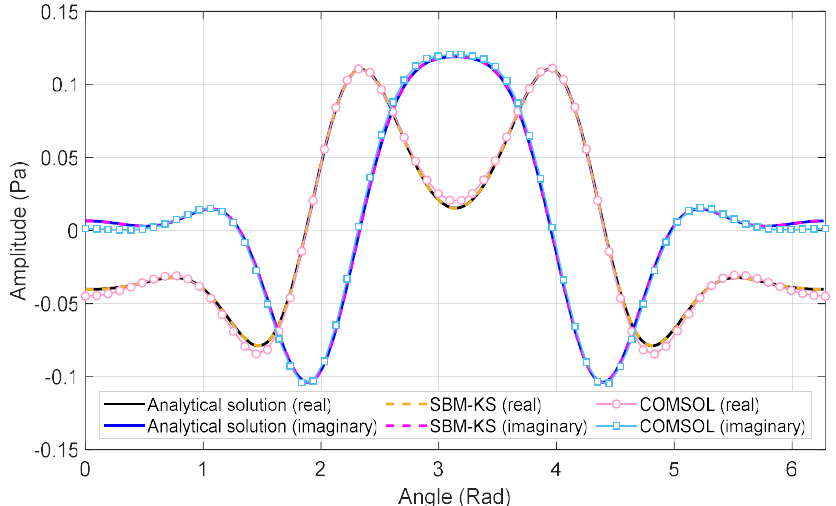
Figure 3. Comparison of the numerical and analytical solutions for hydrodynamic pressures along the common interface under a frequency of 1000 Hz.